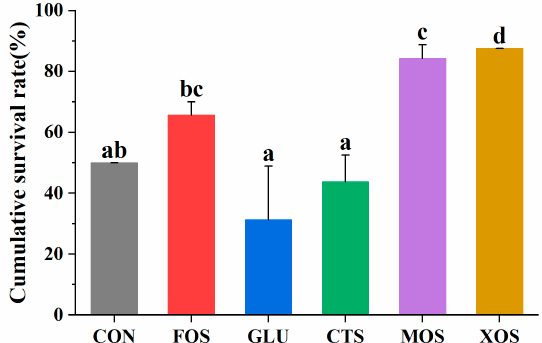
Figure 6. Effects of different prebiotics on the survival rate of hybrid grouper after 24h crowding